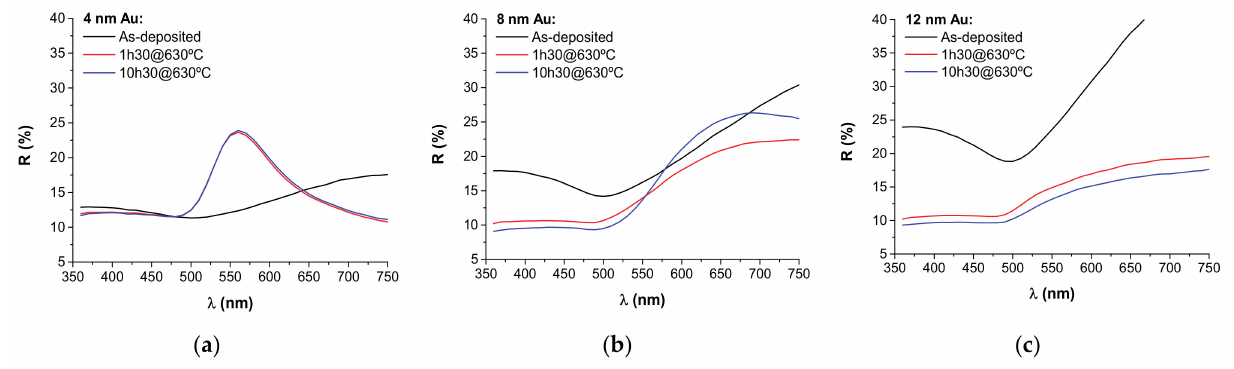
Figure 4. Reflectivity plots in the visible spectra of each sample before and after thermal annealing treatments at 630 ◦ C for different times: ( a ) 4 nm Au; ( b ) 8 nm Au; ( c ) 12 nm